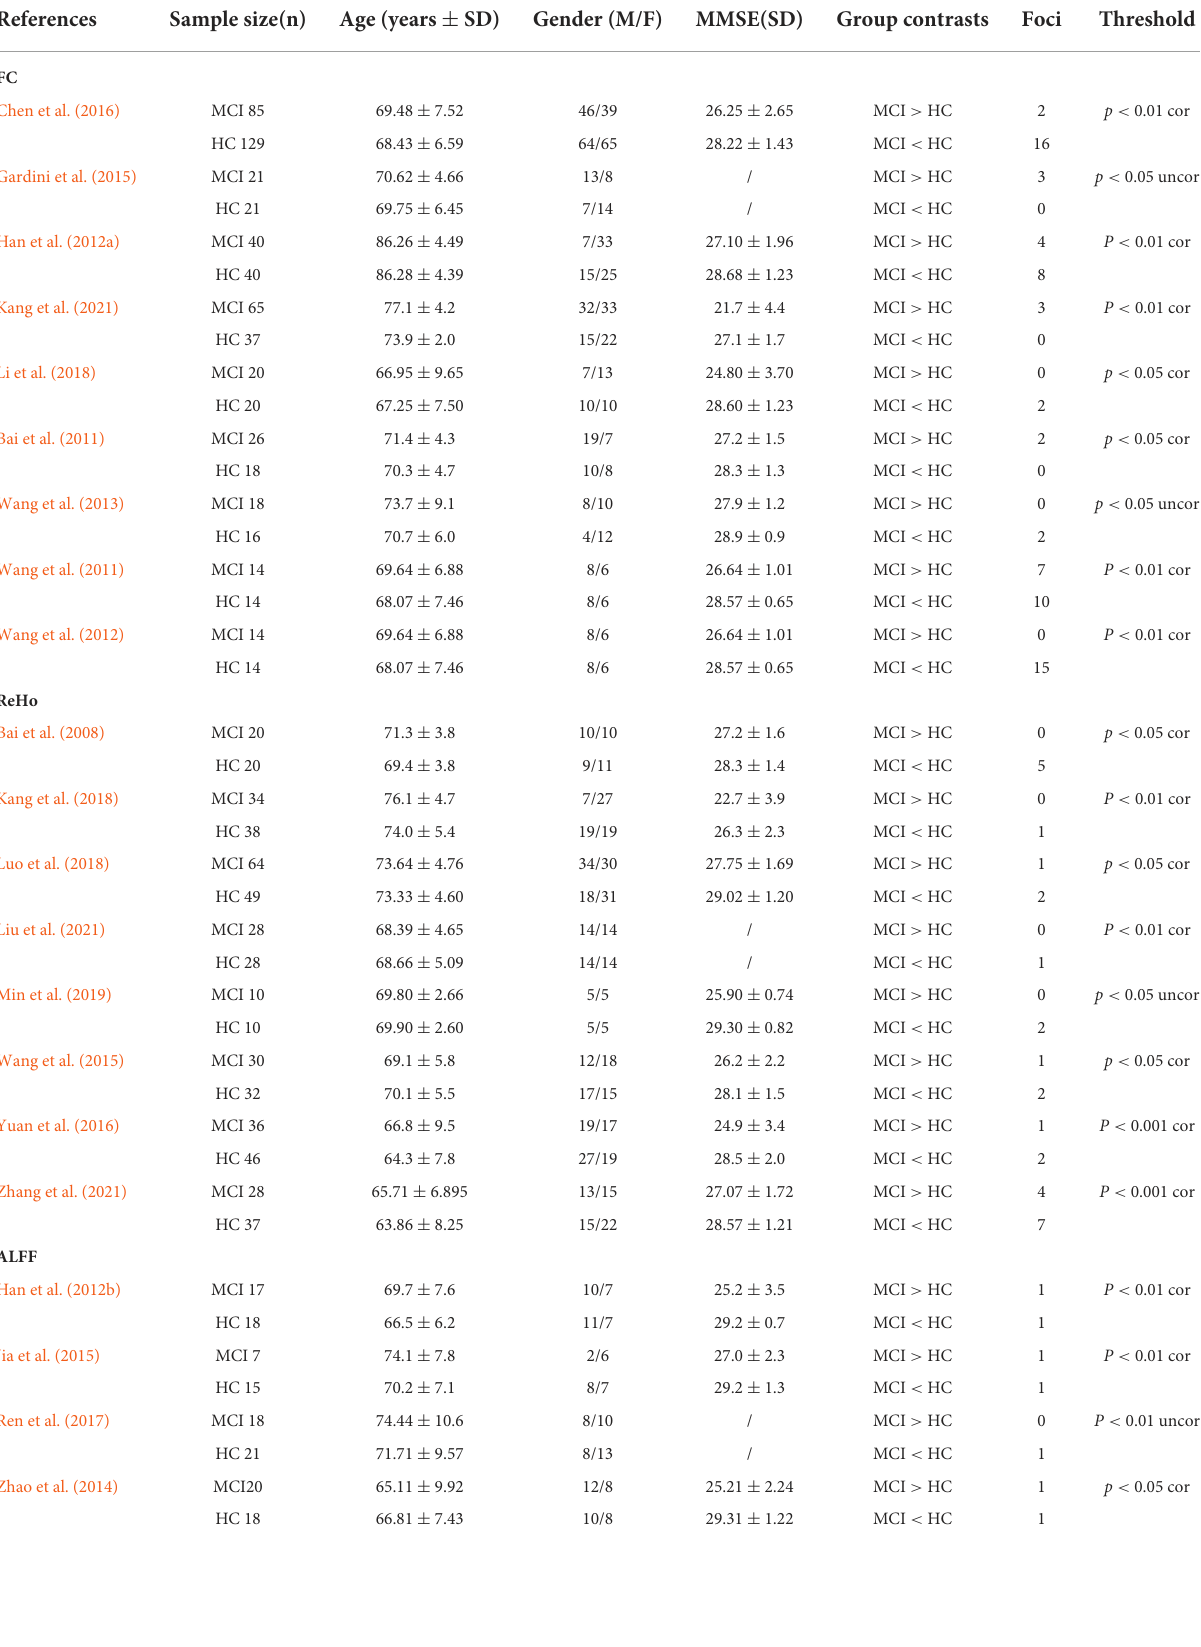
TABLE 1 Demographic characteristics of the included rs-fMRI